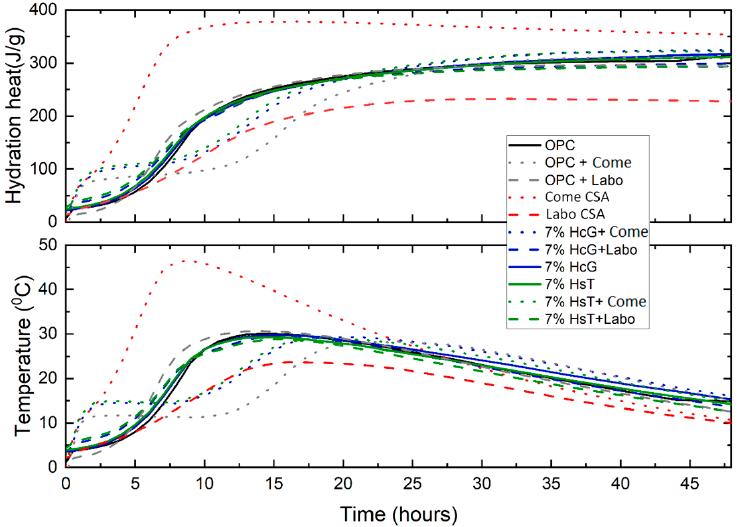
Figure 4. Hydration heat and temperature reached in the mortars, as measured by Langavant calo- rimetry.